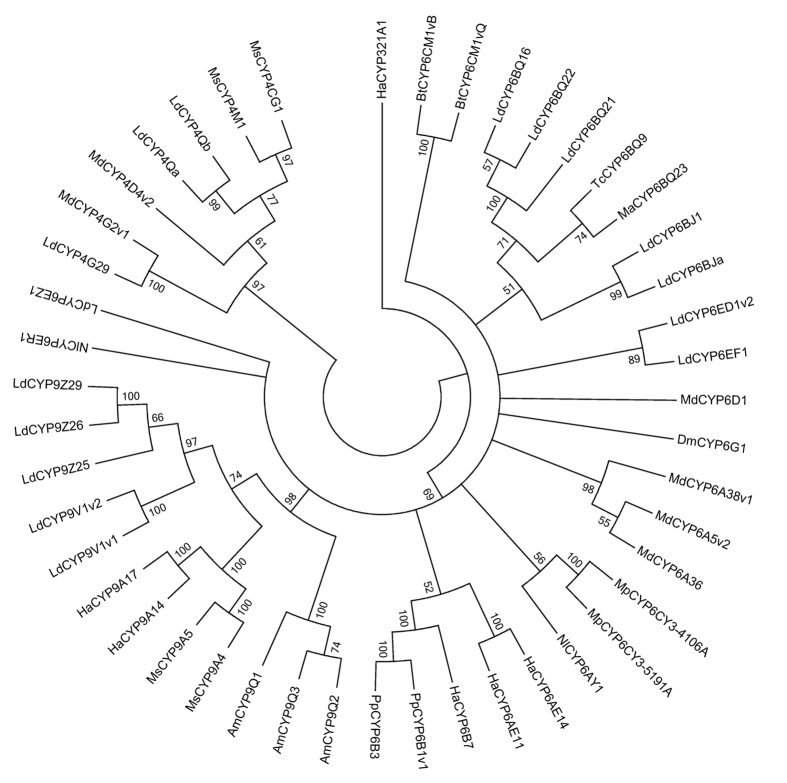
Phylogeny of P450 genes involved in xenobiotics adaptation among insect species.Am, Apis mellifera; Bt, Bemisia tabaci; Dm, Drosophila melanogaster; Ld, Leptinotarsa decemlineata; Ha, Helicoverpa armigera; Ma, Meligethes aeneus; Md, Musca domestica; Mp, Myzus persicae; Ms, Manduca sexta; Nl, Nilaparvata lugens; Pp, Papilio polyxenes; Tc, Tribolium castaneum. The phylogenetic consensus tree was generated by MEGA v6.06 according to the amino acid sequences. The branch support was given by posterior probabilities. The condensed tree was created with cut-off value of 50%.